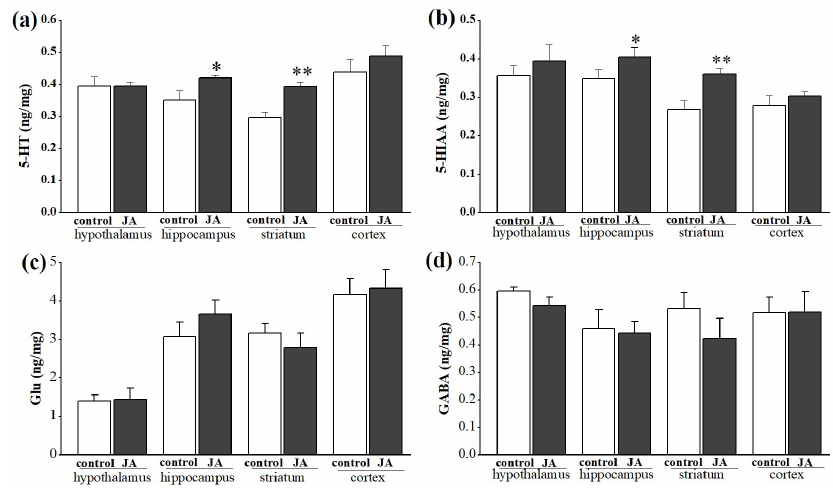
Figure 7. Effects of 3 mg/kg of jegosaponin A (JA) on the content of 5-HT ( a ), 5-HIAA ( b ), Glu ( c ) and GABA ( d ) in different brain regions of the mice. Data are displayed as mean ± SD. * p < 0.05, ** p < 0.01 vs. vehicle group.